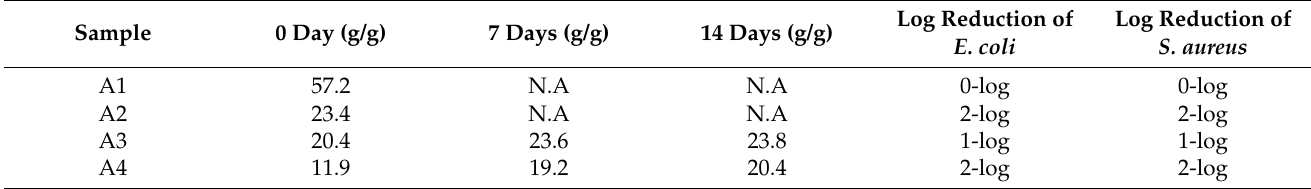
Table 2. In vitro water uptake and viable bacterial reduction of aerogel samples (Sample A1 and A2 referred to as not applicable (N.A.) as they have collapsed in the water after 7